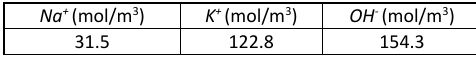
Table 3. Composition of the synthesized interstitial solution based on the dosing of a CEM‐I concrete recreated in a previous study